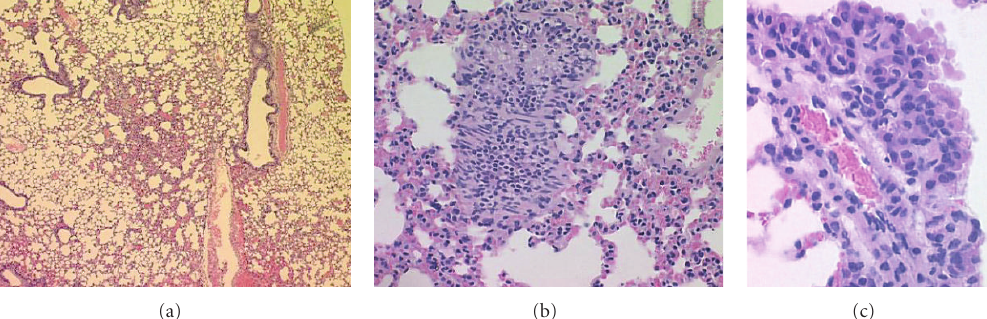
Figure 5: Pulmonary metastasis of the experimental osteosarcoma established by G292 cells. Lung sections stained with H & E. Panel (a) is a micrograph at 25 × magnification, (b) shows the metastatic lesion at 200 × , while panel (c) at 400 ×